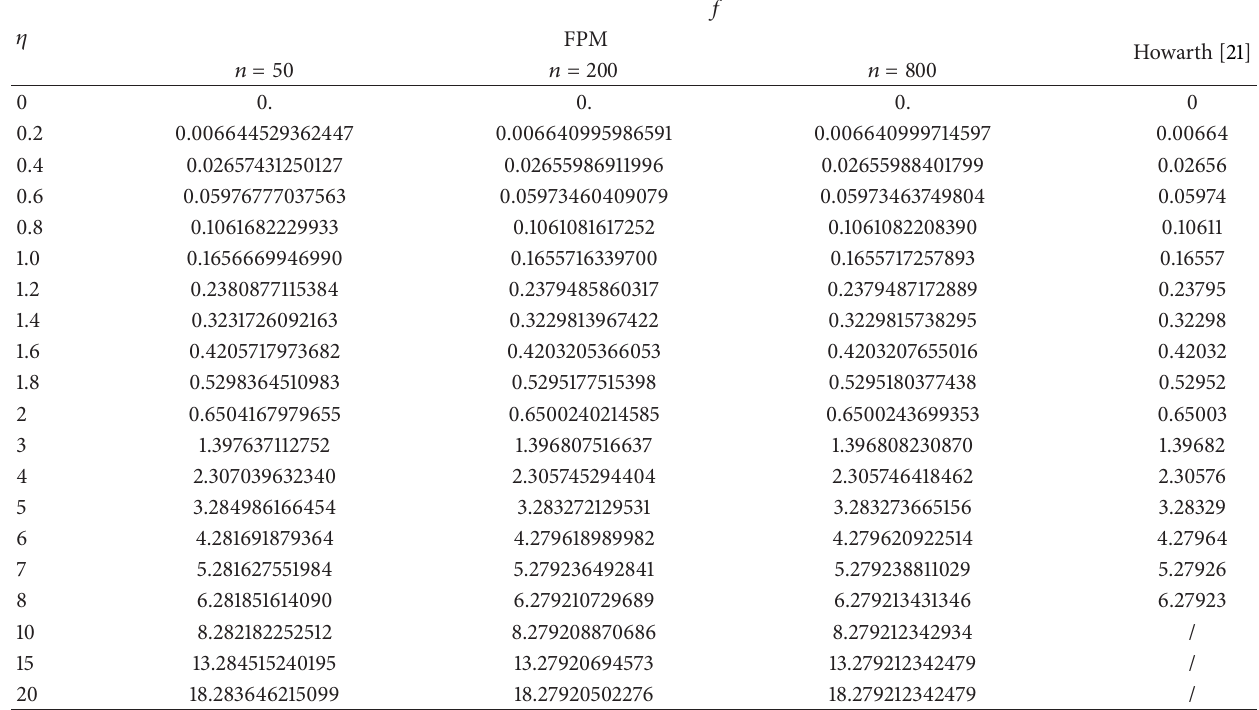
Table 2: Comparison of 𝑓 between FPM ( 𝜆 = 1/5 ) and Howarth.